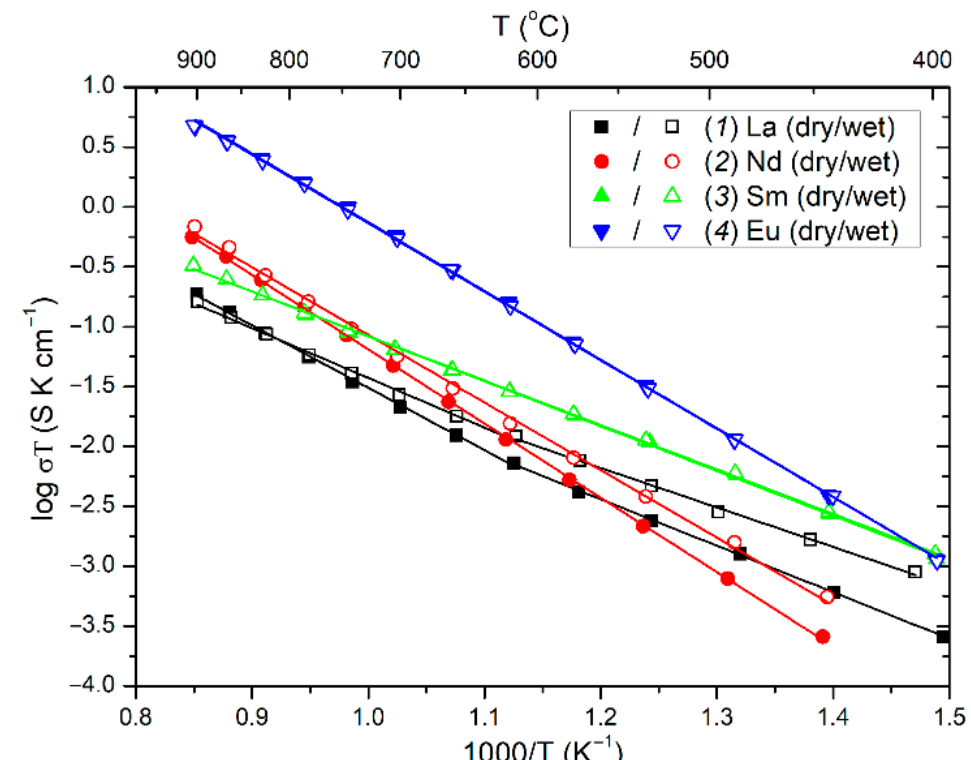
Figure 3. Arrhenius plots of conductivity for different Ln 2 (Hf 1.9 Ln 0.1 )O 6.95 “stuffed” hafnate py- rochlores ((1) Ln = La; (2) Nd [22]; (3) Sm [16]; (4) Eu) [16] in dry and wet air. Table 3. Apparent activation energy (E a ) of total conductivity temperature dependences of